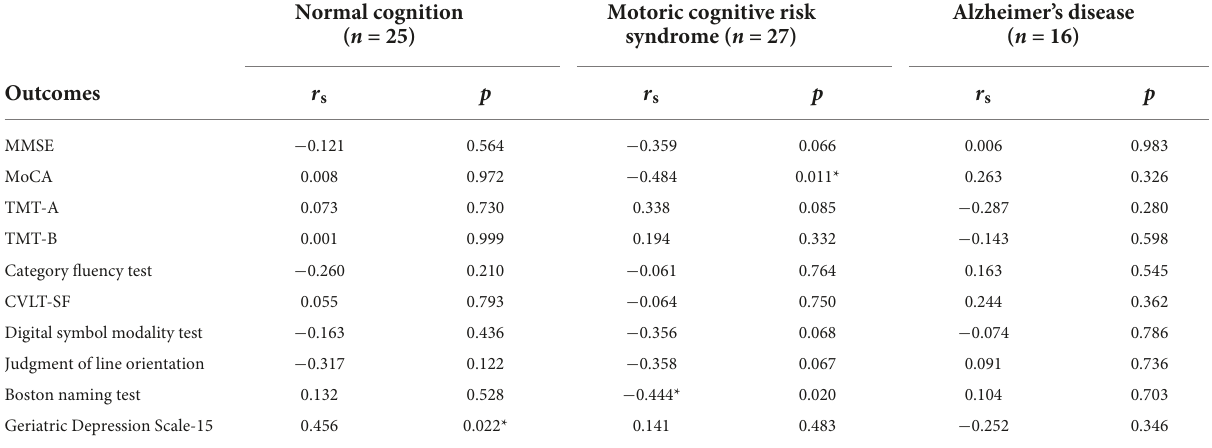
Normal cognition ( n = 25)